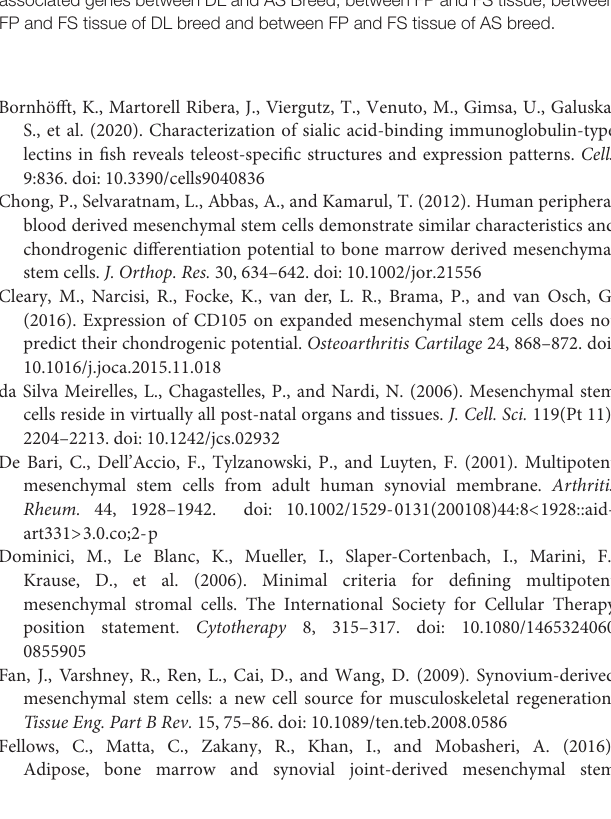
Supplementary Figure 1 | Comparison of the SMSCs differentiation. Supplementary Table 1 | Antibodies used for flow cytometry analysis. Supplementary Table 2 | The number of significant DEGs identified through a comparison between DL and AS breed, between FP and FS tissue, between FP and FS tissue of DL breed and between FP and FS. Supplementary Table 3 | Biological function list of the DEGs between DL and AS Breed, between FP and FS tissue, between FP and FS tissue of DL breed and between FP and FS tissue of AS breed. Supplementary Table 4 | Categories of canonical pathway and their DEGs associated genes between DL and AS Breed, between FP and FS tissue, between FP and FS tissue of DL breed and between FP and FS tissue of AS